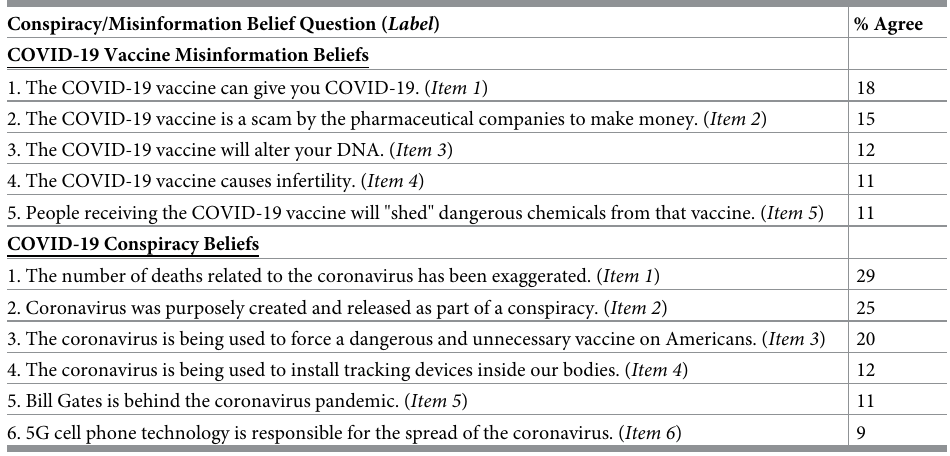
Table 1. Proportion of Americans who believe in COVID-19 conspiracy theories and misinformation. Conspiracy/Misinformation Belief Question ( Label